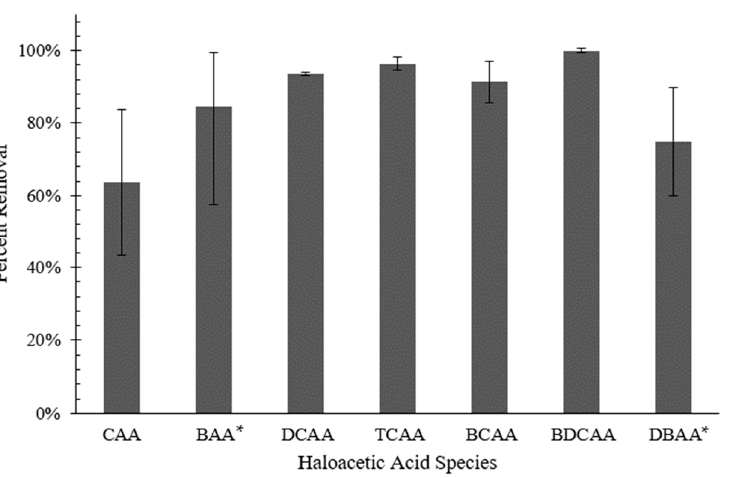
Figure 4. Percent removal of chloroacetic (CAA), bromoacetic (BAA) *, dichloroacetic (DCAA), trichloroacetic (TCAA), bromochloroacetic (BCAA), bromodichloroacetic (BDCAA), and dibromoacetic (DBAA) * acids after the recirculating batch reactor experiments. n = 9. * Formed below the limit of quantification. Error bars represent standard deviation.